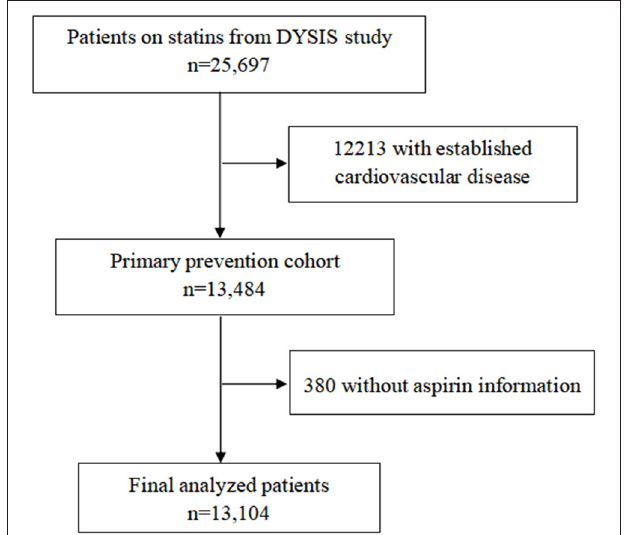
FIGURE 1 | Flow chart of study participants.